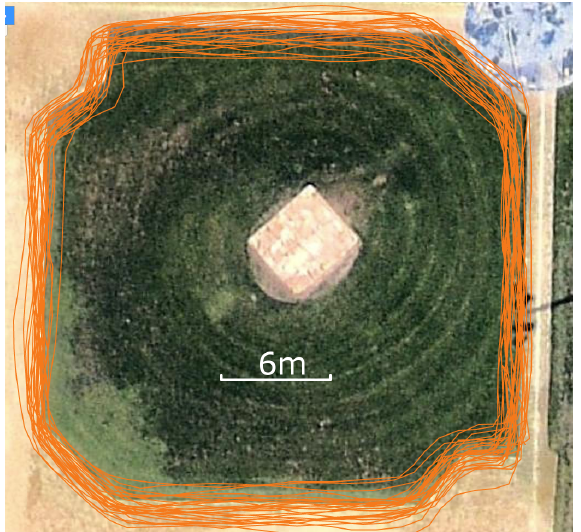
Figure 13. Results from Experiment 3 with 26 labs of corrected path showing a closer accuracy particularly for the